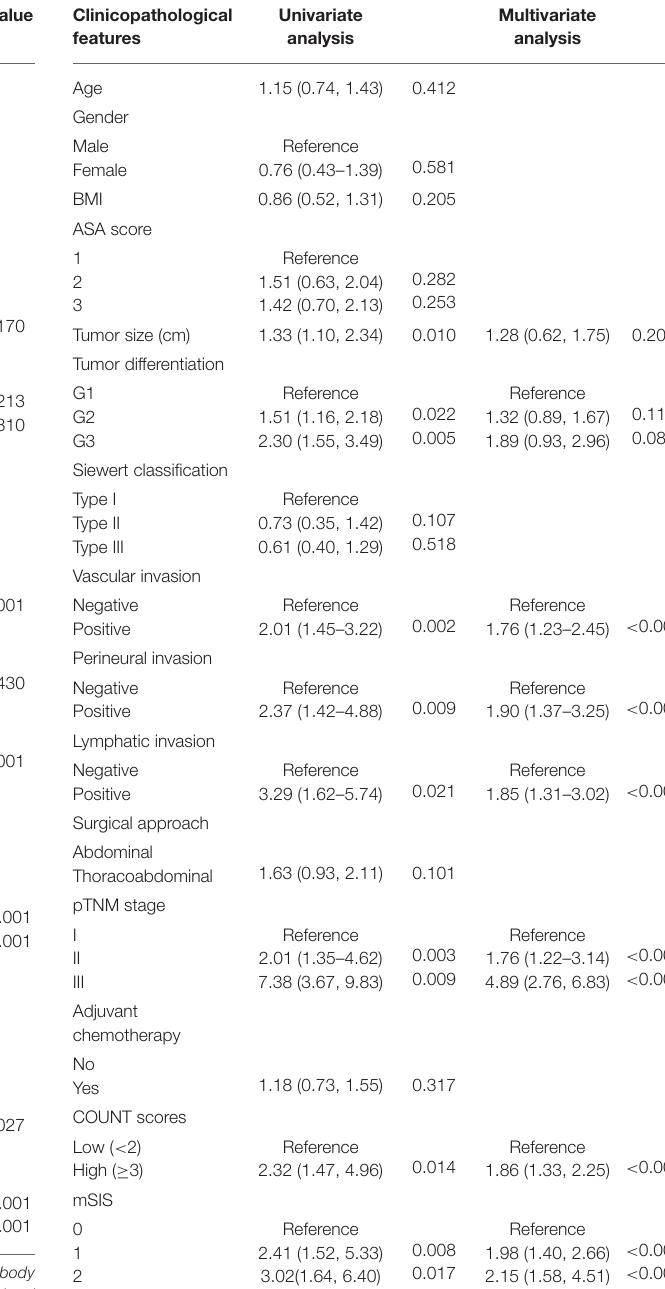
TABLE 3 | Univariate and multivariate analysis of clinicopathologic variables in relation to RFS in patients with AEJ. Clinicopathological Univariate Multivariate features analysis